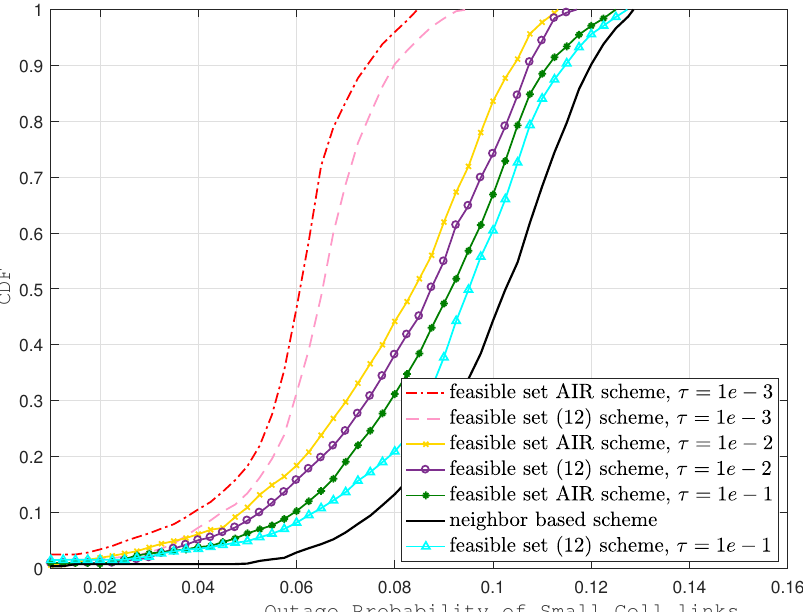
Figure 5. Outage probability of small cell links with various schemes.